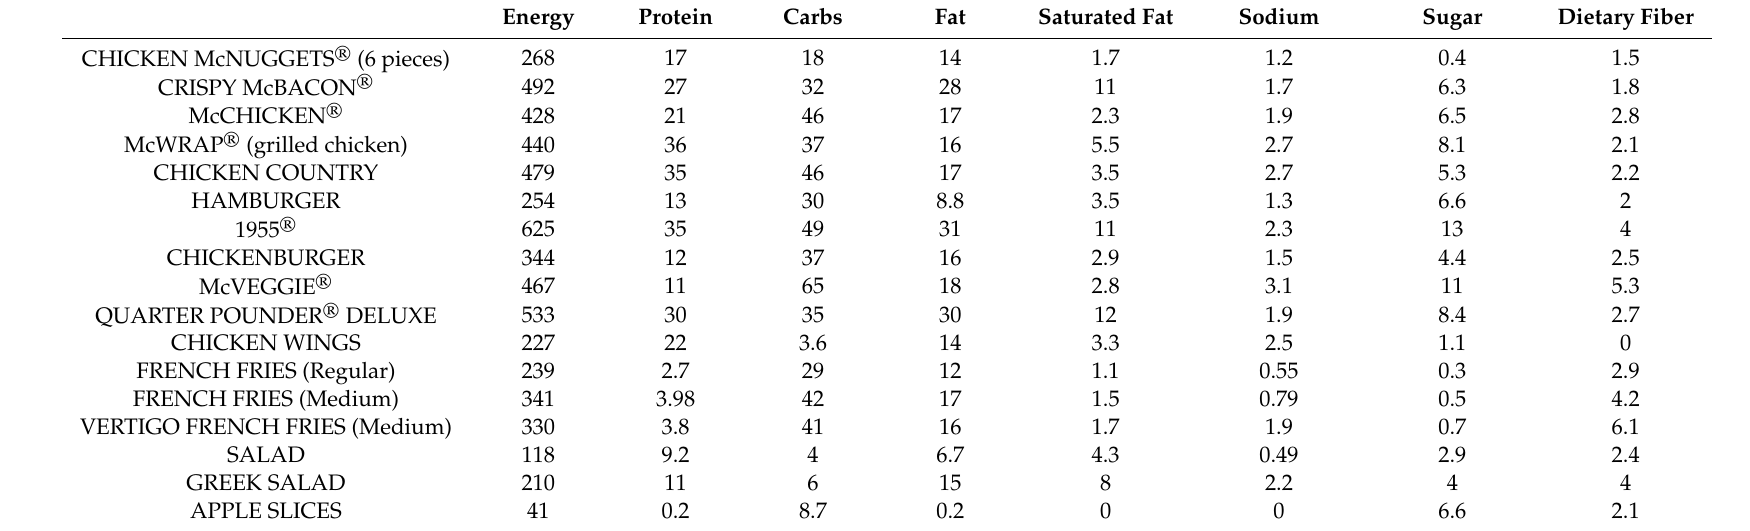
Table 1. Nutritional information for food items included in the